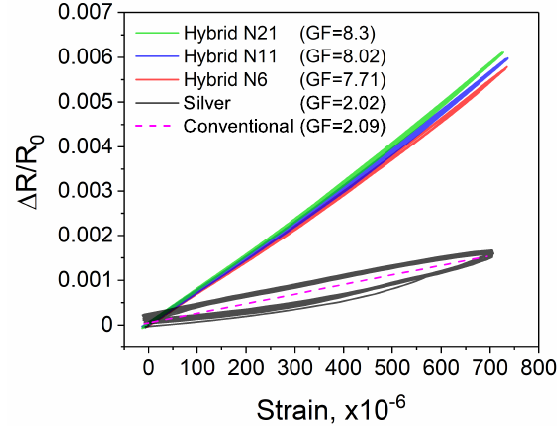
Figure 11. Calibration curves of the sensors with hybrid construction and the sensor entirely made of silver. For reference, the calibration curve of the conventional sensor was